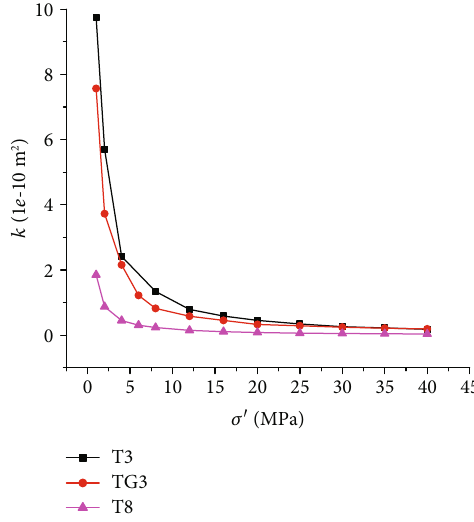
Figure 8: Experimental intrinsic permeability as a function of the e ff ective con fi ning